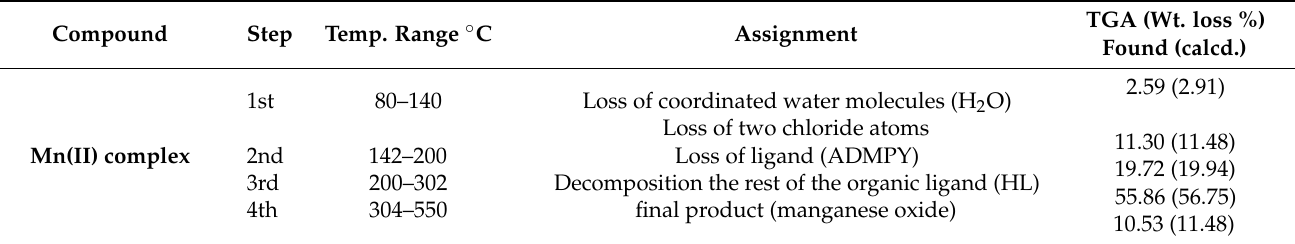
Table 3. Thermal decomposition data of complexes.